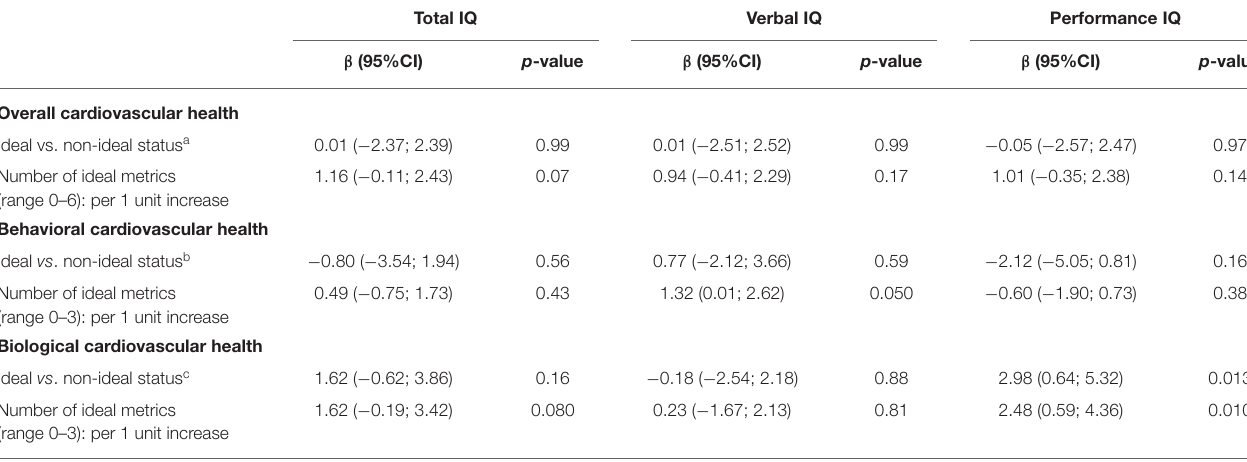
TABLE 3 | Cross-sectional association between cardiovascular health and intelligence quotient (IQ) in children at 5 years of age. Total IQ Verbal IQ Performance IQ β (95%CI) p -value β (95%CI) p -value β (95%CI) p -value Overall cardiovascular